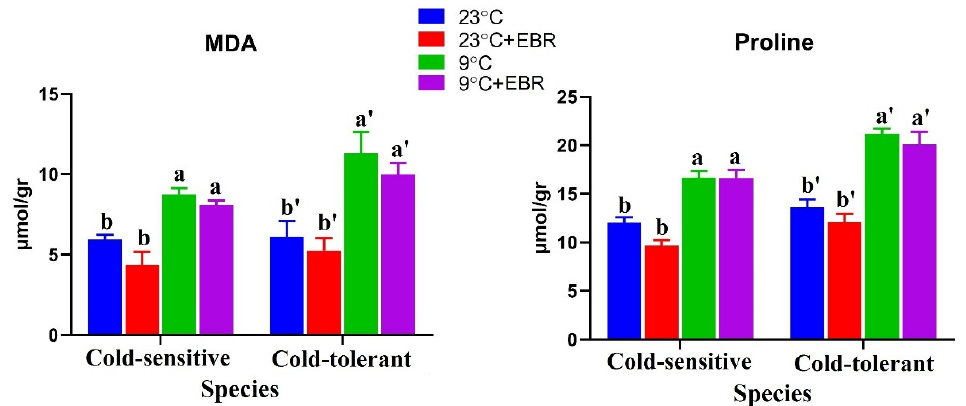
Figure 3. The profile of MDA and proline content under low-temperature stress and EBR treatment.